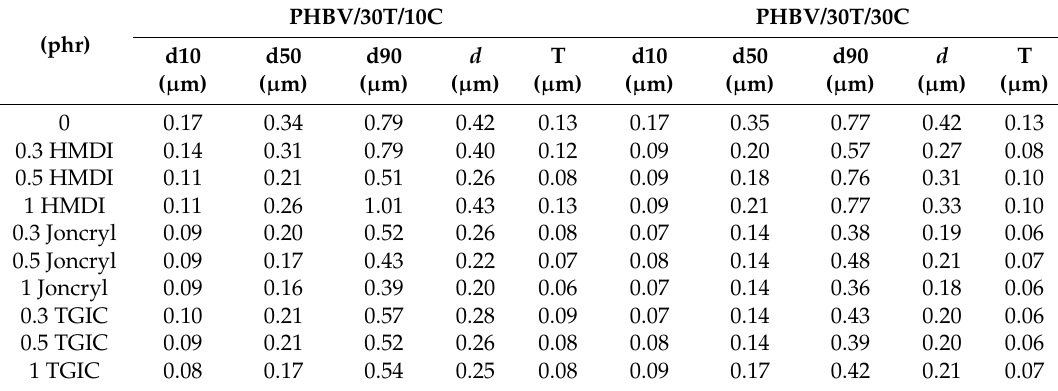
Table 2. Estimated d10, d50 and d90, average droplet size and ligament distance values of the TPU dispersed